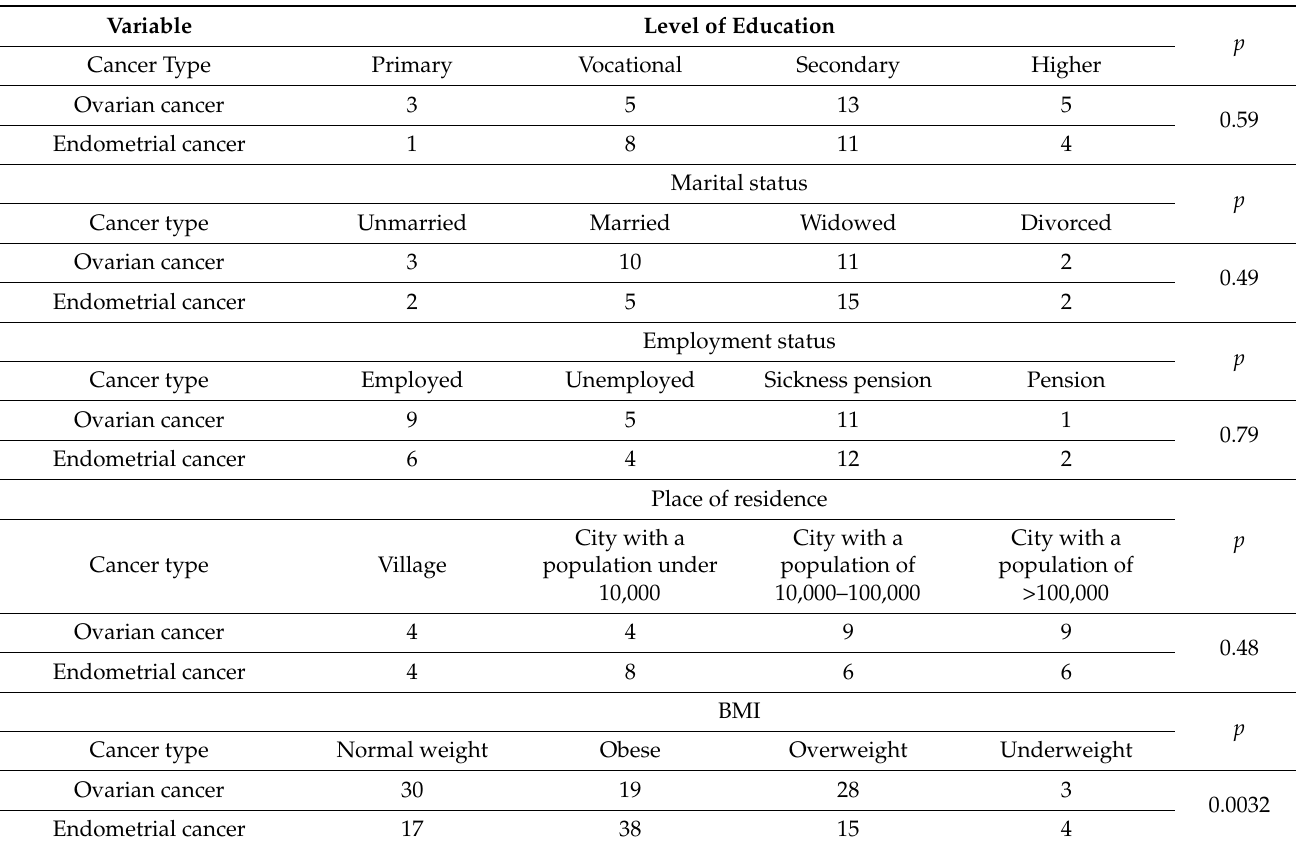
Table 1. Sociodemographic